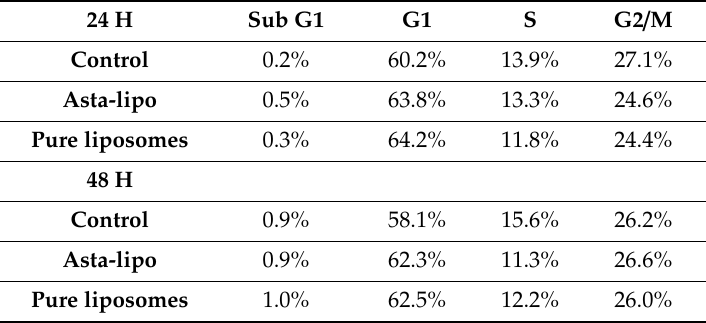
Table 1. Analysis of cell cycle distribution of normal L929 fibroblasts exposed to Asta-lipo and pure liposomes for 24 and 48 h.